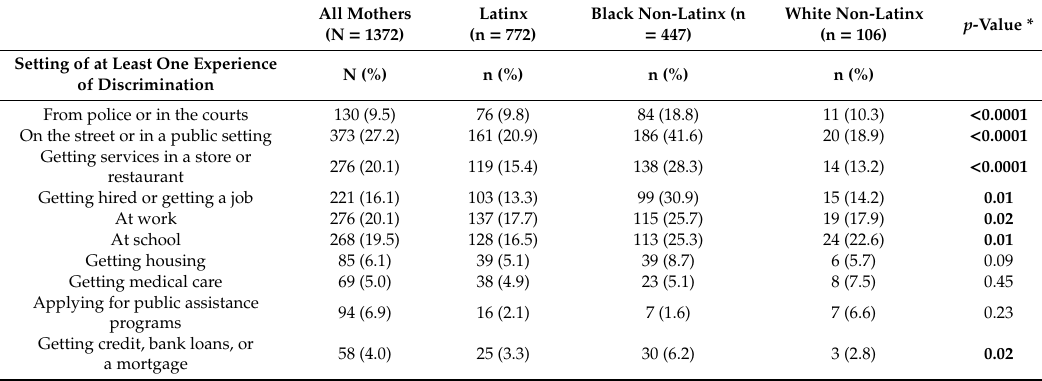
Table 2. Experiences of Discrimination by Race / Ethnicity (N = 1372) ‡